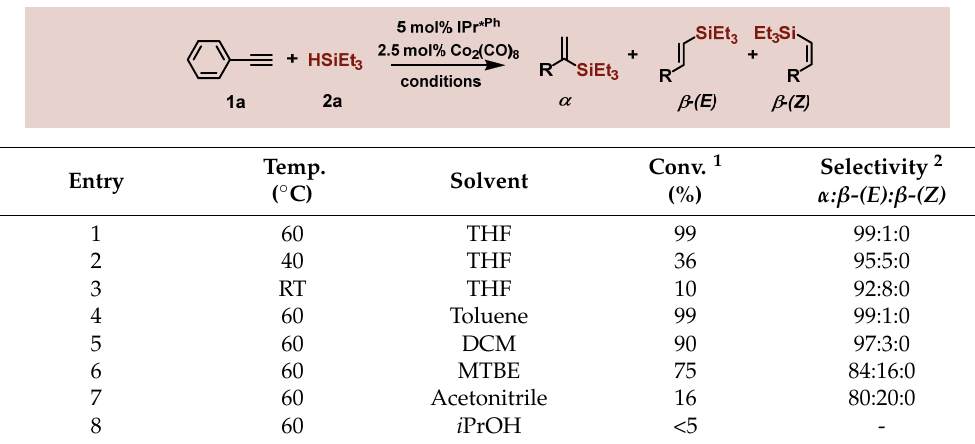
Table 2. Optimization of reaction conditions—solvent and temperature.